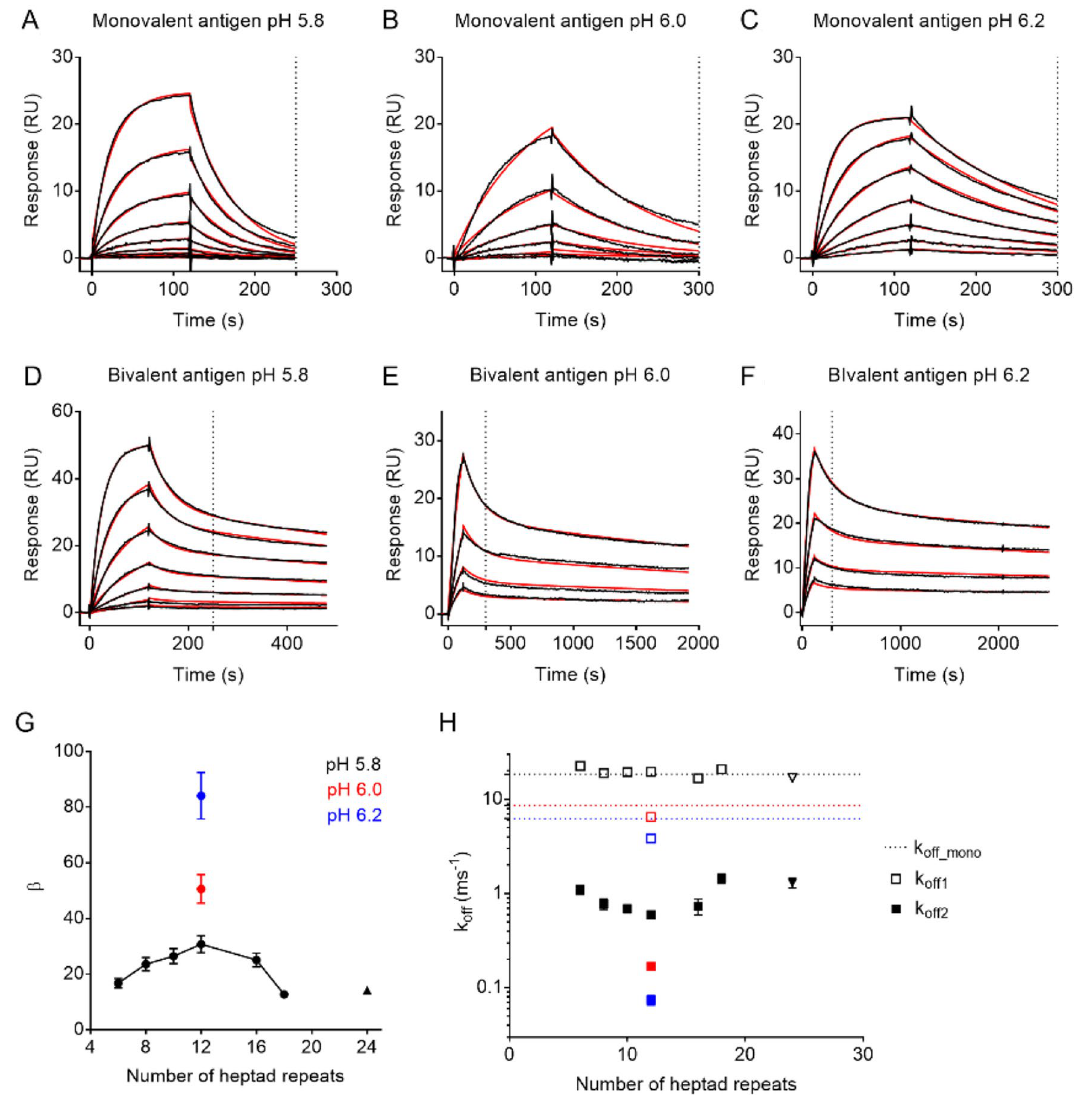
Figure 3. Evaluation of avidity enhancement by surface plasmon resonance. Representative sensorgrams of APH half (monovalent) and APH 12 (bivalent) binding to the anti-His antibody at various pH are shown in ( A ) to ( F ). 250 s ( A , D ) or 300 s ( B , C , E , F ) are marked. Each line represents a single antigen concentration from the dilution series injected over the chip surface. Raw data is shown in black with 1:1 ( A , B , C ) or bivalent analyte ( D , E , F ) fit shown in red. The bivalent binding produces a biphasic dissociation curve with a fast component (k off1 ) coming from the monovalent interaction and slow component (k off2 ) coming from the bivalent interaction (k off_bi ). The affinity enhancement (β) expressed as a fold decrease in the k off_bi as compared with k off_mono determined for monovalent antigen is shown in ( G ). The log(k off ) values of all antigen variants are summarized in ( H ) with log(k off1 ) and log(k off2 ) are shown as open and full symbols respectively. k off_mono is the dissociation rate constant of the monovalent antigen (APH half